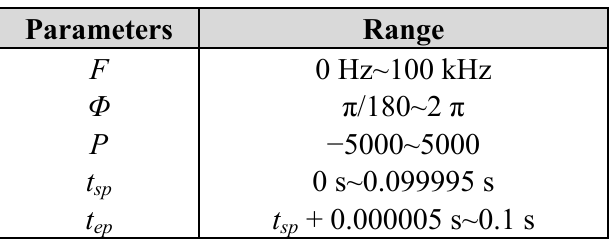
Table 1. Range of